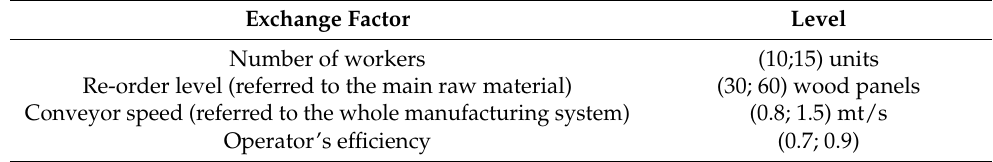
Table 1. The exchange factors. Exchange Factor Level Number of workers (10;15)